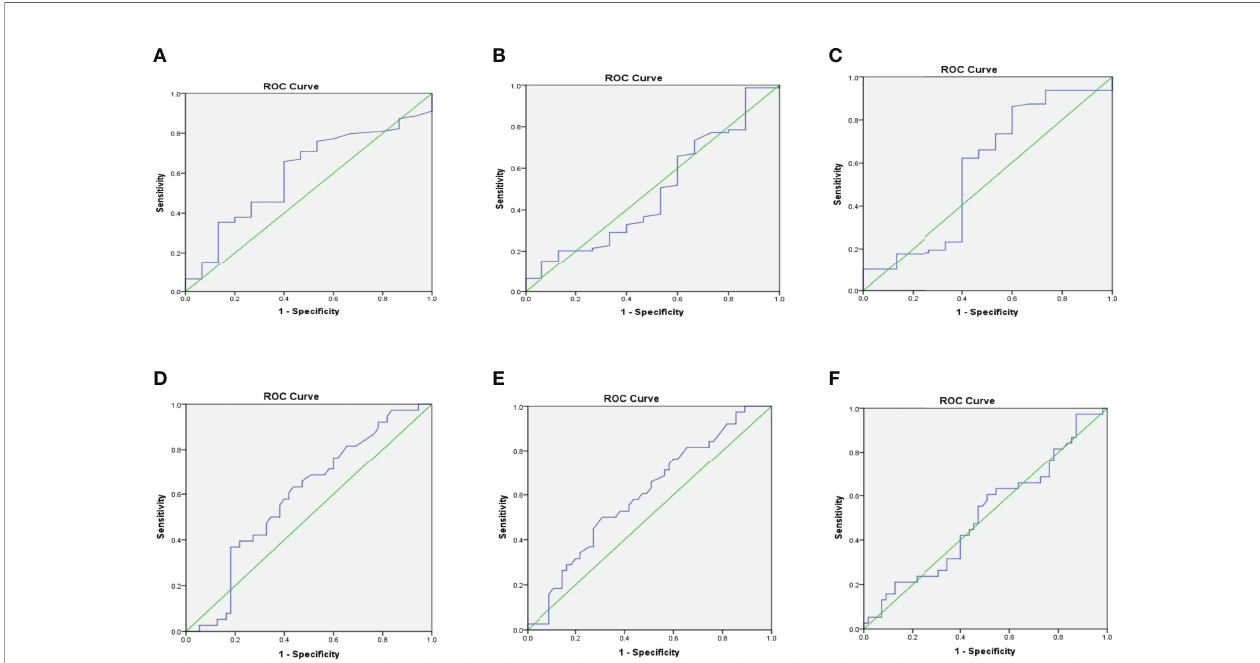
FIGURE 3 | Receiver operating characteristic (ROC) curves for Kappa (A) , Lambda (B) , and K: L ratio (C) for predicting albuminuria; and Kappa (D) , Lambda (E) , and K: L ratio (F) for predicting